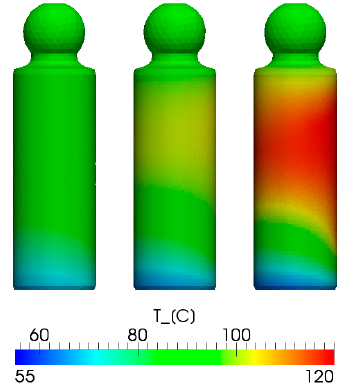
Figure 17. Piston temperature distribution comparison for different sizes.